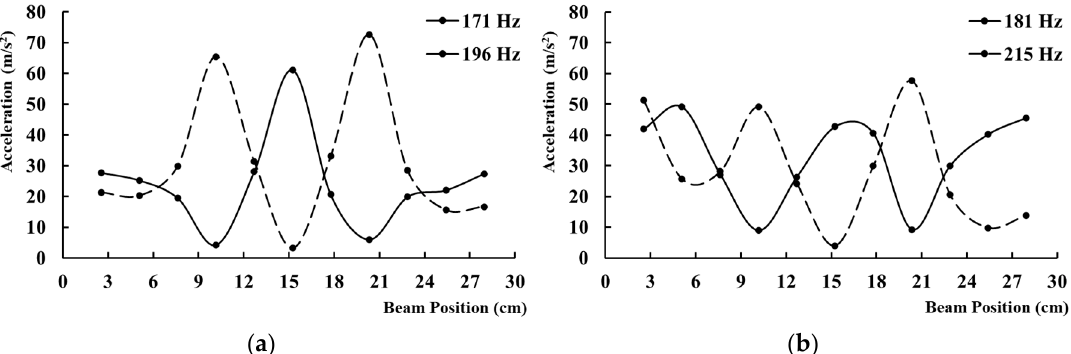
Figure 7. Unique vibration mode shapes that were experimentally measured when exciting: ( a ) a single actuator at 171 or 196 Hz; ( b ) both actuators at 181 and at 215 Hz.